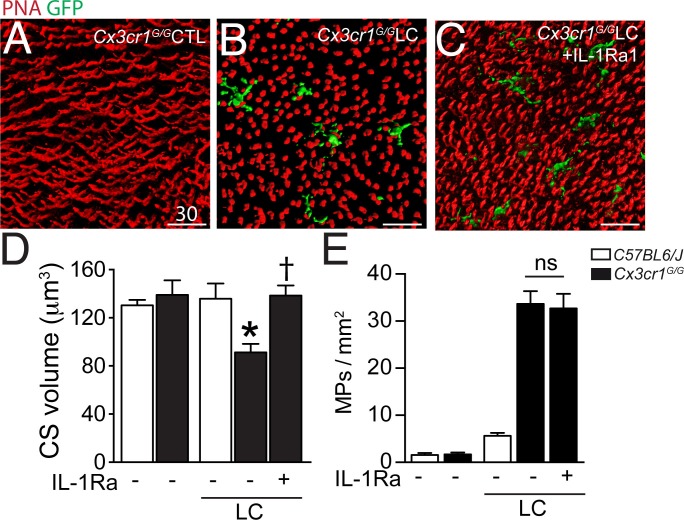
Cone segments in light-induced subretinal inflammation of C57BL6/J and Cx3cr1GFP/GFP-mice and the effect of pharmacological IL-1β inhibition.(A–C) Orthogonal projections of confocal Z stack images of the photoreceptor segments of peanut agglutinin (PNA, red) stained Cx3cr1GFP/GFP-mice (expressing GFP under the Cx3cr1 promoter) that were kept under normal light conditions (A), or exposed to an inflammation-inducing light-challenge (LC) and treated with PBS (B) or IL-1β receptor antagonist (C, IL-1Ra). (D and E) Quantification of cone segment volume (D) and subretinal mononuclear phagocytes (E) in normal light raised and LC-mice (n = 5–8/group; Kruskal-Wallis, Dunn’s post test *p=0,0109 versus Cx3cr1GFP/GFP-mice in normal light; †p=0,0028 versus light-challenged Cx3cr1GFP/GFP-mice). PNA: peanut agglutinin; GFP: green fluorescent protein; IL-Ra: IL-1β receptor antagonist LC: illuminated/light-challenged. Scale bar 30 μm.